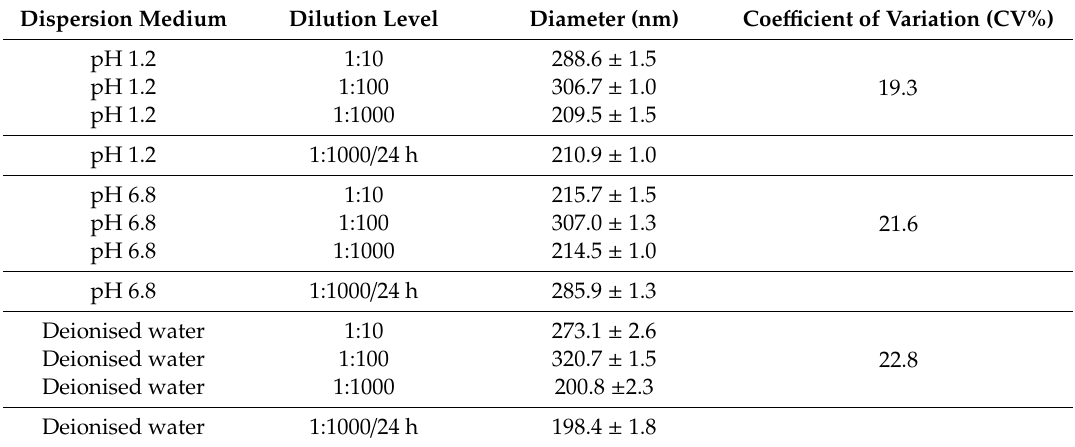
Table 5. Droplet diameter of drug loaded sonicated emulsions at di ff erent pH media and